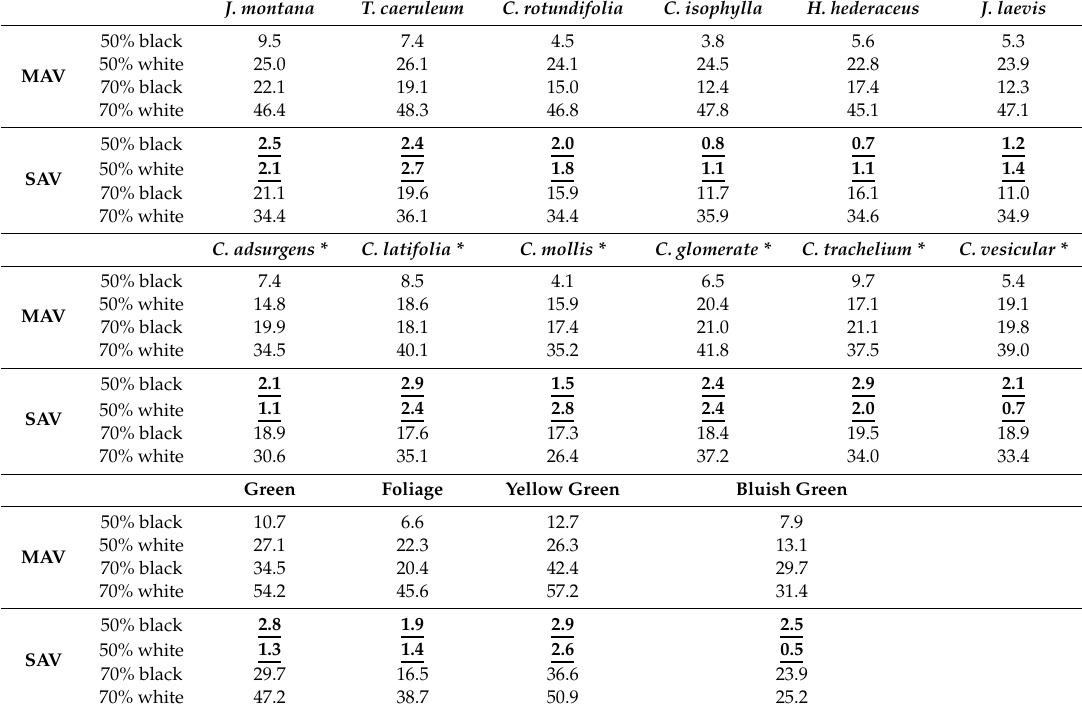
Table 2. Colorimetric analysis (total color di ff erences, ∆ E* ab ) of the measurements with black 50%, white 50%, black 70% and white 70% adaptors, compared to those obtained with no adaptor. ∆ E* ab below the threshold of perception ( < 3.0 CIELAB units) are in bold and underlined. Plants marked with an asterisk (*) are dry material from herbarium